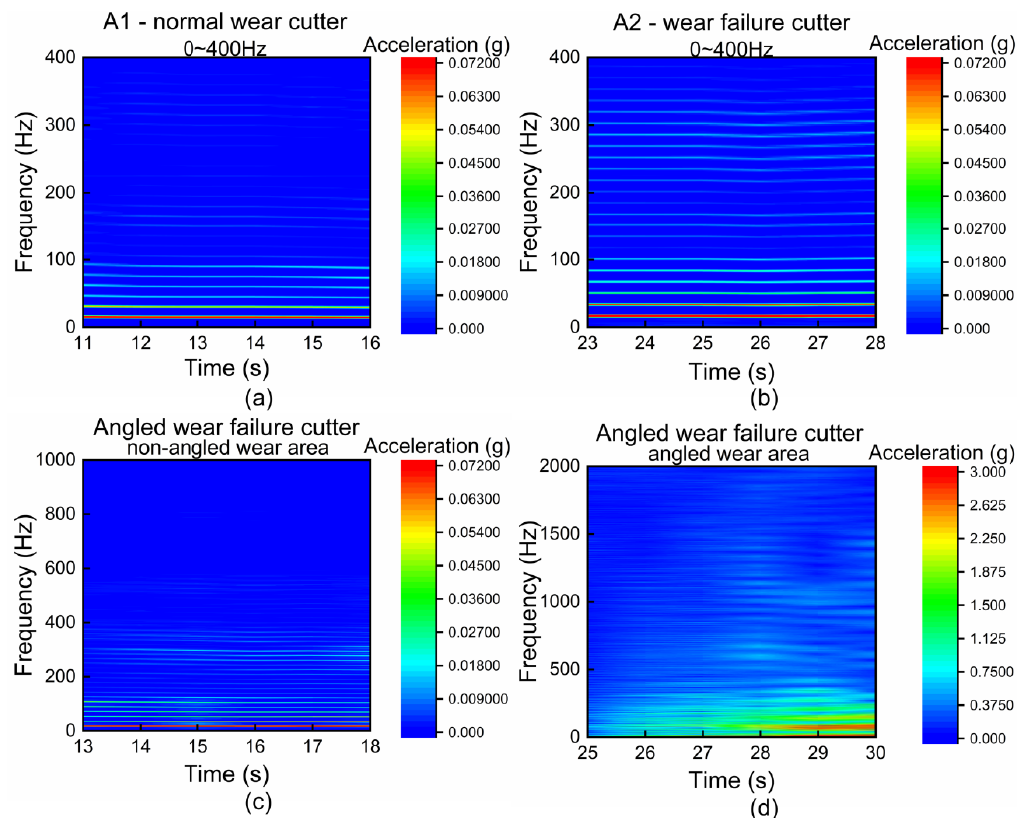
Figure 6. Granite sample, penetration 2 mm, frequency domain characteristics of different cutters: ( a ) normal wear cutter, A1 area, 0~400 Hz; ( b ) wear failure cutter, A2 area, 0~400 Hz; ( c ) angled wear failure cutter (non-angled wear area), 0~1000 Hz; ( d ) angled wear failure cutter (angled wear area), 0~2000 Hz.